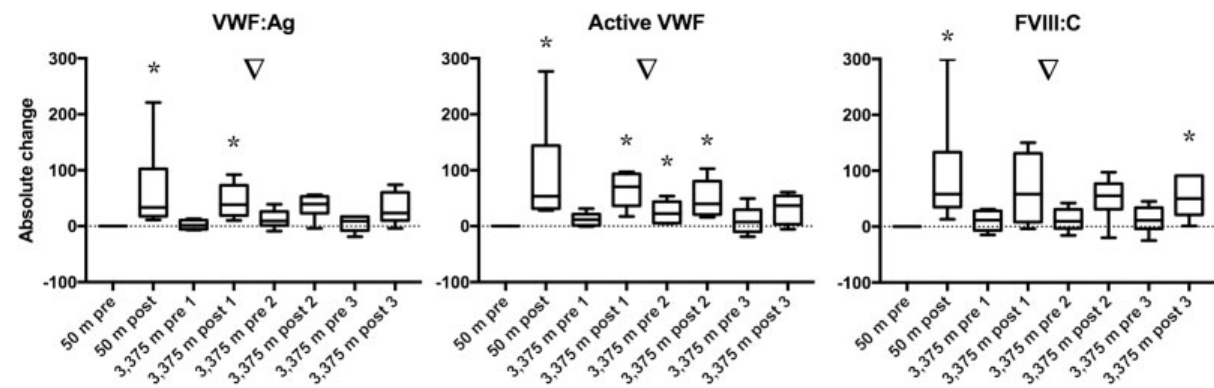
Fig. 2 Normoxic and hypoxic exercises increased von Willebrand factor antigen (VWF:Ag) levels, active VWF, and factor VIII concentration (FVIII:C). Results are expressed as the absolute change of 50 m pre-exercise; a value above 0 indicates an increase, and a value below 0 indicates a decrease. 5 ¼ p < 0.05 (Friedman ’ s test); (cid:5) ¼ p < 0.05 compared with zero (Wilcoxon signed-rank